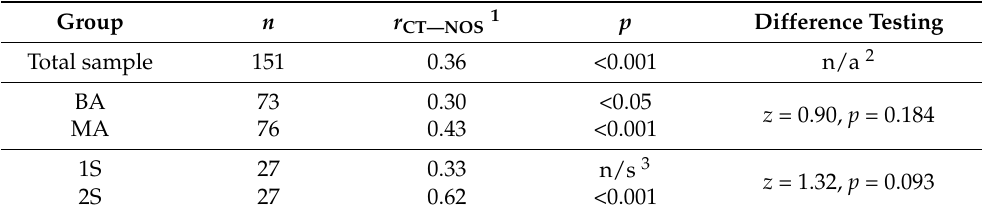
Table 5. Results of correlation analyses and comparisons of relationships between CT skills and NOS